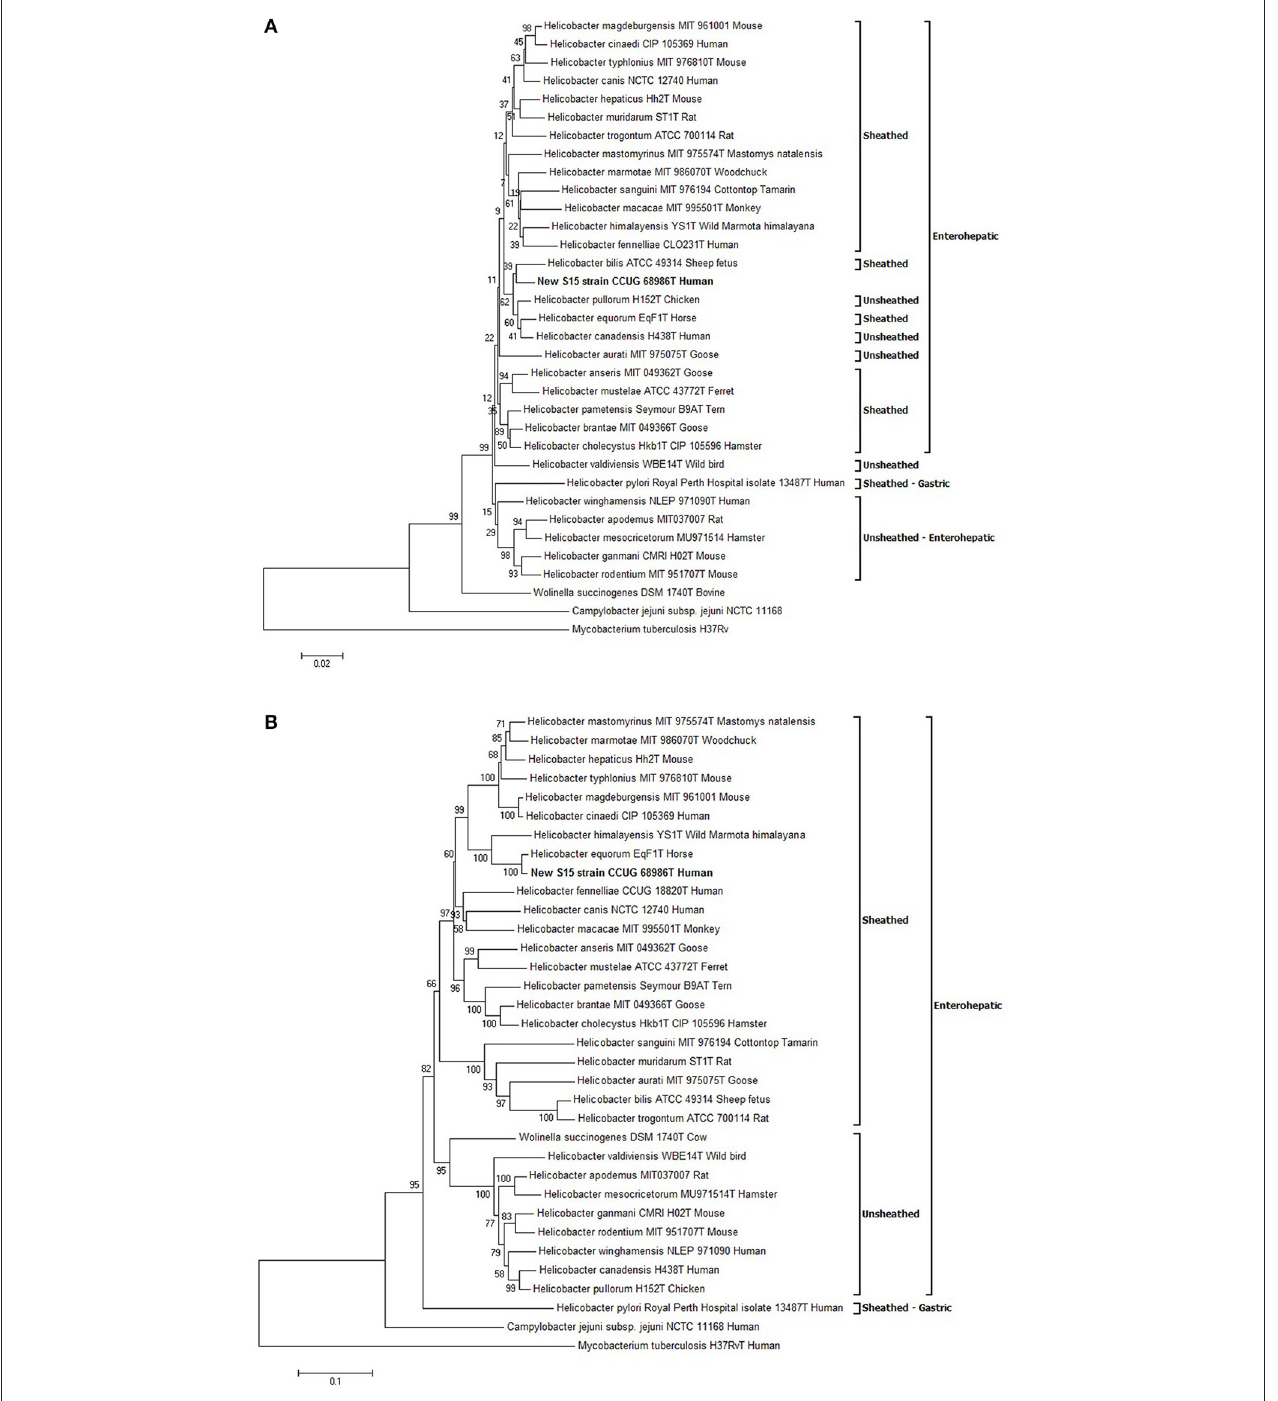
FIGURE 3 | Phylogenetic trees. Evolutionary relationships of Helicobacter taxa based on the 16S rRNA gene (A) and GyrA protein encoded gene (B) . The phylogeny presented is based on the alignment of approximately 1,400 nucleotides of the 16S rRNA gene and 700 residues of the GyrA protein. The phylogenetic analyses were generated with the neighbor-joining method. The percentage of replicate trees in which the associated taxa clustered together in the bootstrap test (1,000 replicates) is shown next to the branches. The trees are not rooted and drawn to scale, with branch lengths in the same units as those of the evolutionary distances used to infer the phylogenetic tree. The evolutionary distances were computed using the Kimura 2-parameter method for 16S rRNA gene, the Poisson correction method for GyrA and are represented in the units of the number of base substitutions per site. The analysis included 34 sequences. All ambiguous positions were removed for each sequence pair. Evolutionary analyses were conducted using MEGA6. All sequences are labeled according to species, strain name, collection number in brackets . Mycobacterium tuberculosis was used as the outgroup sequence. All accession numbers are provided in Supplementary Table S2.